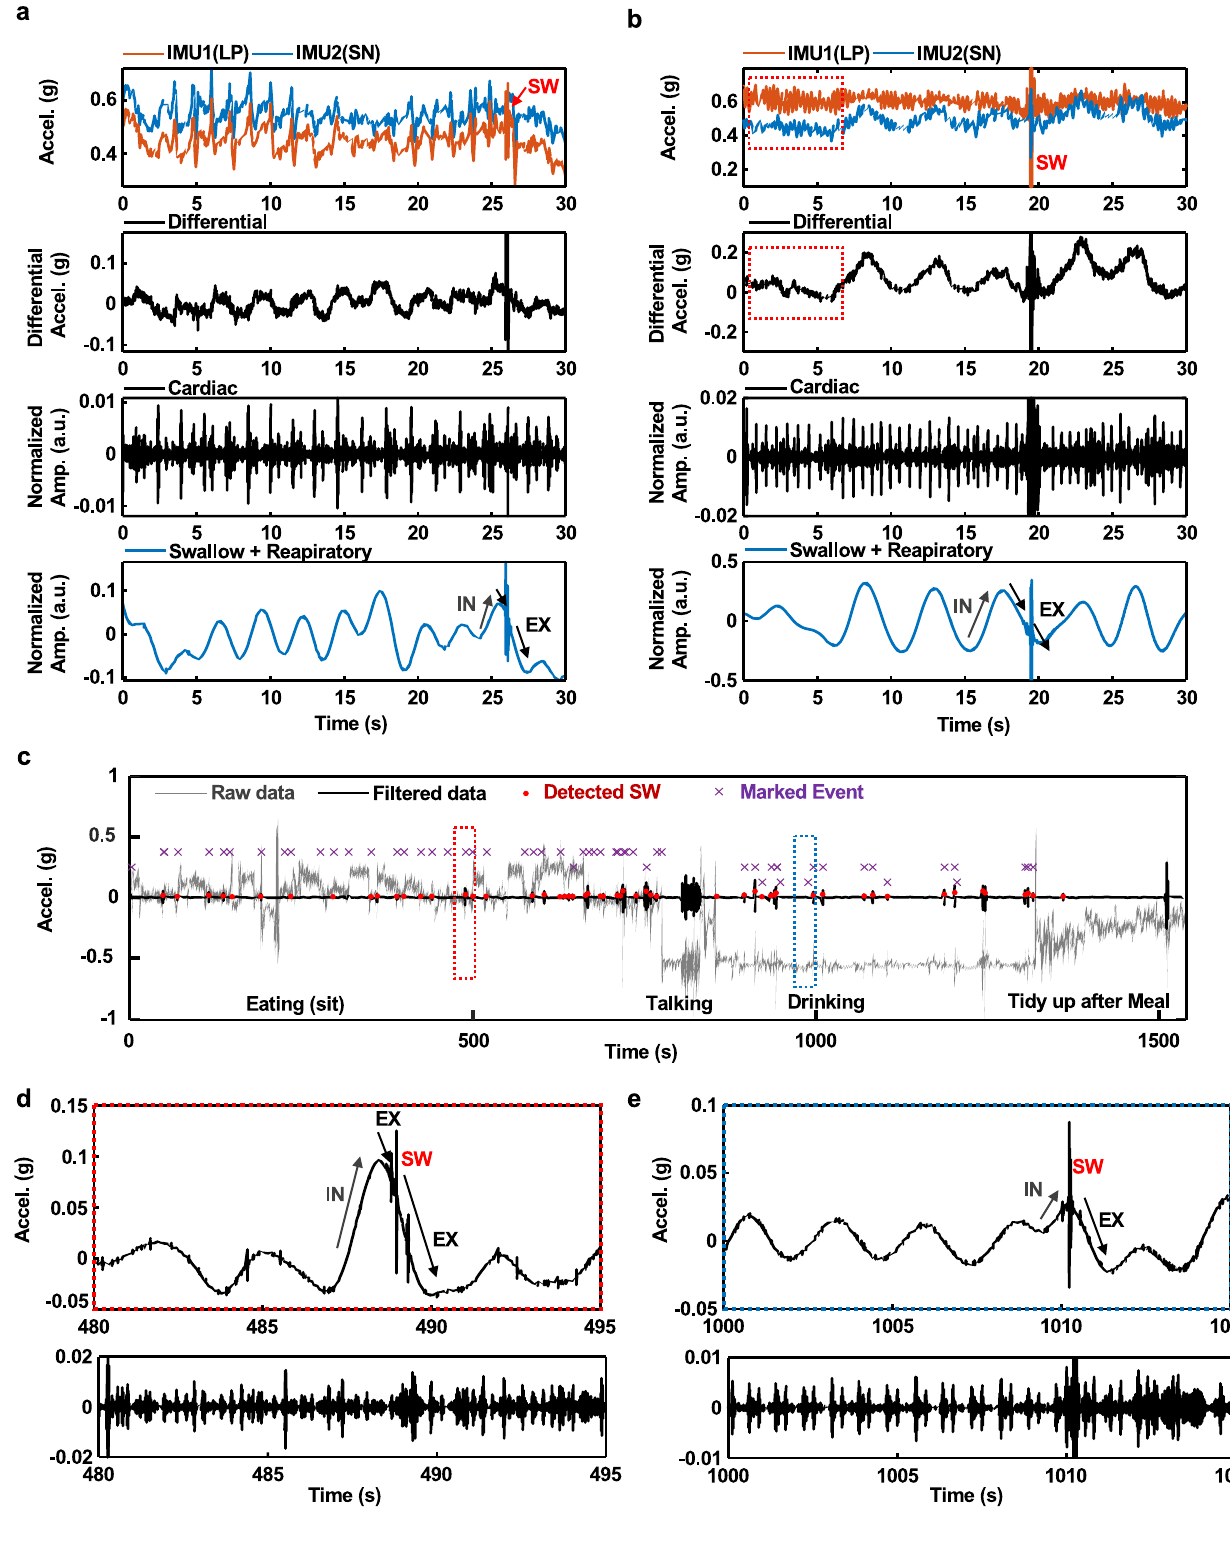
bottom layer and pouring uncured liquid prepolymer of silicone along the outline (Eco fl ex 00-30, Smooth-On Inc.) on the top layer and curing (70 °C for 30 min) established a mechanical bond to seal the fPCB from the external environment. Lastly, a CO 2 laser cutting system (VLS2.30, Universal Laser Systems) formed the fi